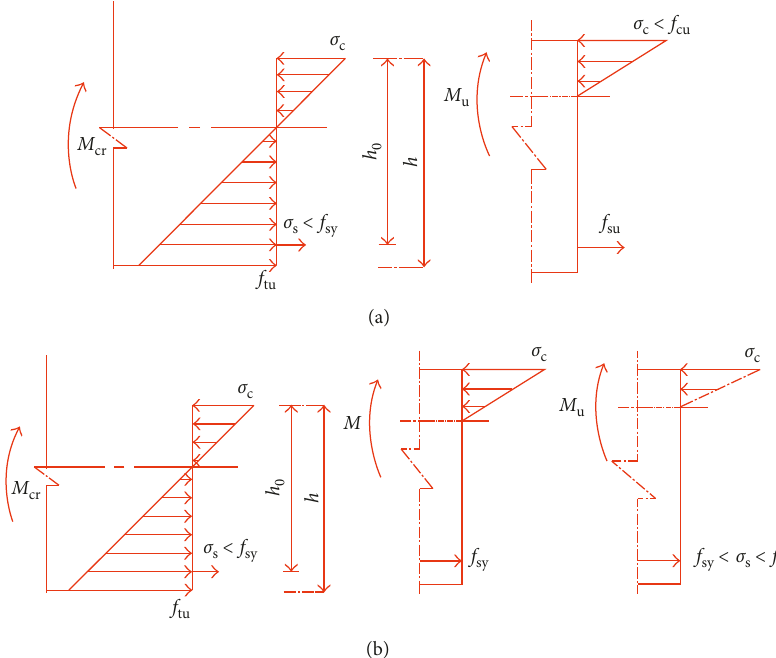
Figure 49: Cross-sectional stress profile of the stone slab with NSM screw-thread steels. (a) The cross section stress profile of brittle failure mode: (A) elastic phase before cracking and (B) failure phase after cracking. (b) The cross section stress profile of ductility failure mode: (A) elastic phase before cracking, (B) from the appearance of crack to yielding of screw-thread steels after cracking, and (C) failure